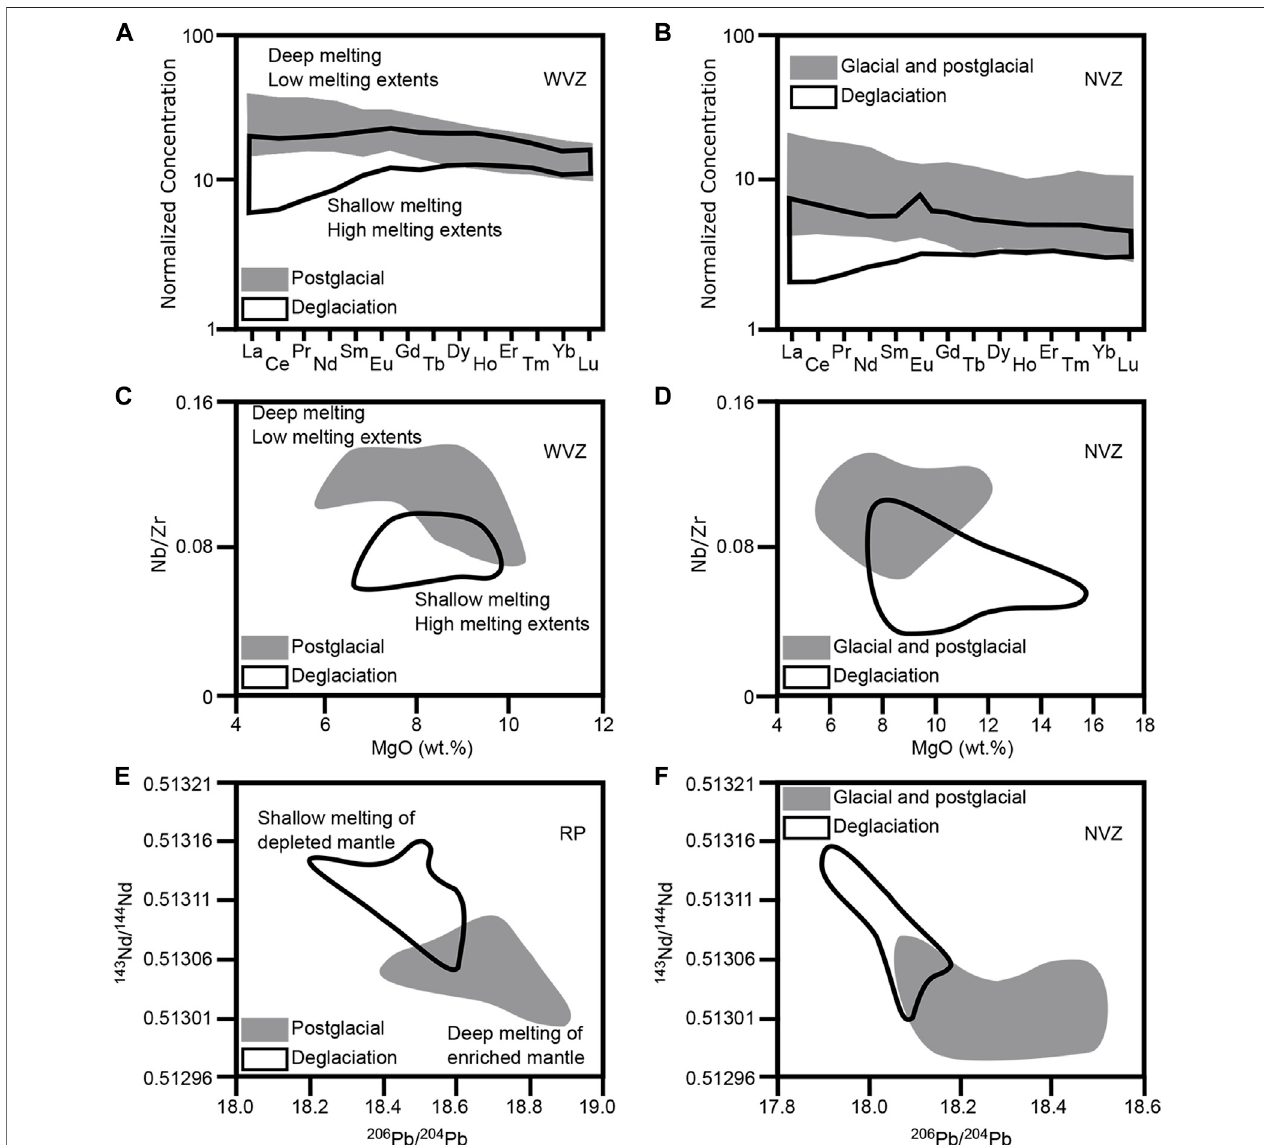
FIGURE 3 | Geochemical trends in lavas erupted during deglaciation compared to isostatic ice conditions. Deglaciation causes increased melting at shallow depths, generating melts that are depleted in Rare Earth Elements (REE), ratios of incompatible elements, and isotopes. (A,B) REE normalized to primitive mantle (McDonough and Sun, 1995) for Iceland ’ s Western Volcanic Zone (WVZ; (A) and Northern Volcanic Zone (NVZ; (B) . (C,D) Trace element ratios asa function of MgO (wt %)fortheWVZ (C) andNVZ (D) . (E,F) NdandPbisotopesfortheReykjanesPeninsula(RP; (E) andNVZ (F) .Gray fi eldsrepresentlavaseruptedduringisostaticice conditions (glacial and postglacial). Open fi elds represent lavas erupted during deglaciation. NVZ REE, trace element, and MgO data from Theistareykir from the compilationofMaclennanetal.(2002andreferencesintheirTable2,excludingpicrites)NVZisotopedatafromTheistareykirfromthecompilationofSimsetal.(2013and referencesintheirTable1).WVZREE,traceelement,andMgOdatafromthecompilationofEasonetal.(2015andreferencesintheirFigure4).RPisotopedatafromGee et al.